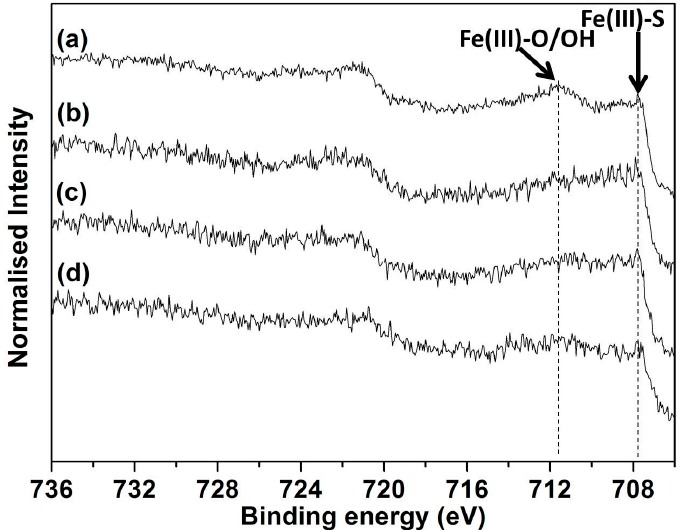
Figure 7. Fe 2 p XP spectra collected from chalcopyrite leached at 750 mV, 75 °C and pH 1.0 for ( a ) 1